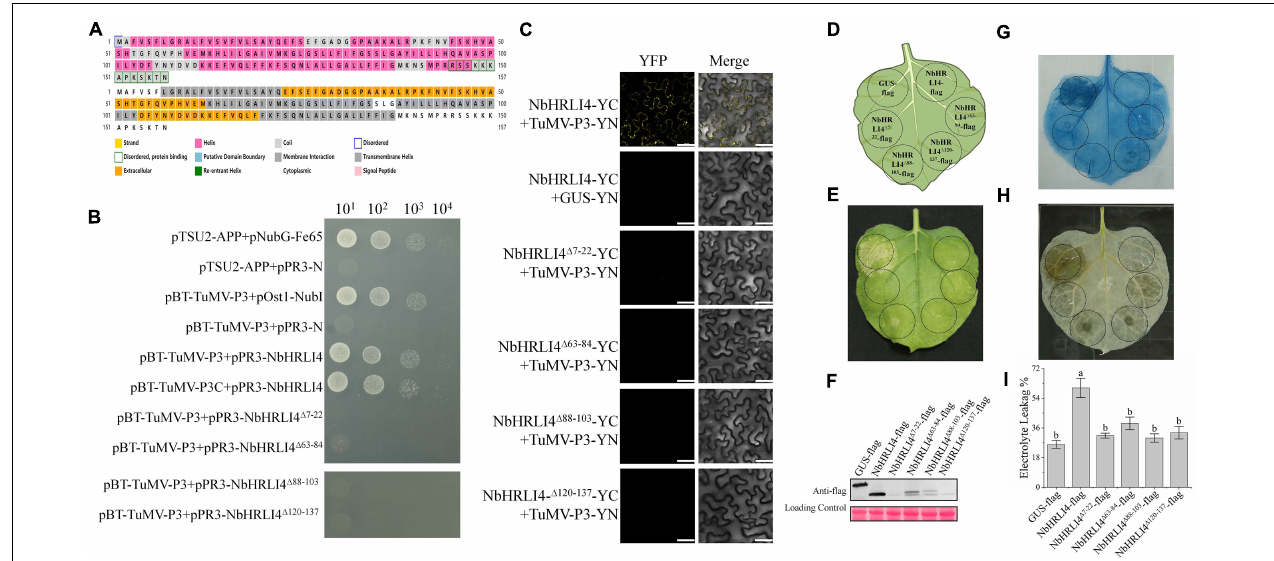
FIGURE 8 | The membrane interaction domains of NbHRLI4 are essential for its interaction with TuMV-P3 and for inducing cell death. (A) Protein structure analysis of NbHRLI4. (B) Y2H assays between pBT-TuMV-P3/pPR3-NbHRLI4, pBT-TuMV-P3C/pPR3-NbHRLI4, pBT-TuMV-P3/pPR3-NbHRLI4 (cid:49) 7 − 22 , pBT-TuMV-P3/pPR3-NbHRLI4 (cid:49) 63 − 84 , pBT-TuMV-P3/pPR3-NbHRLI4 (cid:49) 88 − 103 , and pBT-TuMV-P3/pPR3-NbHRLI4 (cid:49) 120 − 137 . pBT-TuMV-P3 with pPR3-N was used as negative control and pBT-TuMV-P3 with pOst1-NubI was the positive control. (C) BiFC assays were conducted between NbHRLI4/TuMV-P3, NbHRLI4 (cid:49) 7 − 22 /TuMV-P3, NbHRLI4 (cid:49) 63 − 84 /TuMV-P3, NbHRLI4 (cid:49) 88 − 103 /TuMV-P3, and NbHRLI4 (cid:49) 120 − 137 /TuMV-P3. GUS was used as negative control. Bars = 50 µ m. (D) Schematic diagram of transient infiltration of GUS-flag, NbHRLI4-flag, NbHRLI4 (cid:49) 7 − 22 -flag, NbHRLI4 (cid:49) 63 − 84 -flag, NbHRLI4 (cid:49) 88 − 103 -flag, and NbHRLI4 (cid:49) 120 − 137 -flag in panels (E–G) . (E) Overexpression of GUS-flag, NbHRLI4-flag, NbHRLI4 (cid:49) 7 − 22 -flag, NbHRLI4 (cid:49) 63 − 84 -flag, NbHRLI4 (cid:49) 88 − 103 -flag, and NbHRLI4 (cid:49) 120 − 137 -flag in bright at 6 dpi. (F) Western blotting detection of proteins expressed on leaves shown in panel (D) . (G) Trypan blue staining of leaves expressing the vectors in panel (E) at 6 dpi. (H) DAB staining of leaves expressing the vectors in panel (E) at 6 dpi. (I) Leaf disks expressing the vectors in panel (E) were excised and assayed for electrolyte leakage at 6 dpi. The mean expression values were analyzed using F -test. Different letters on histograms indicate significant differences ( P <